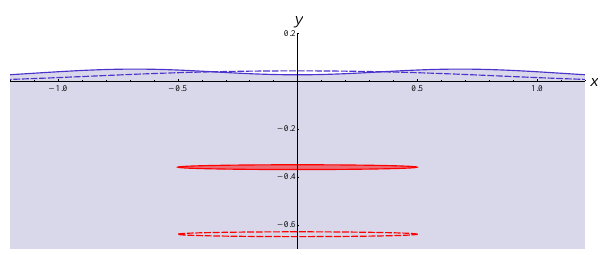
Fig. 2. Formation of diverging waves by slow rising of the obstacle: a = 0 . 5, λ = 15.